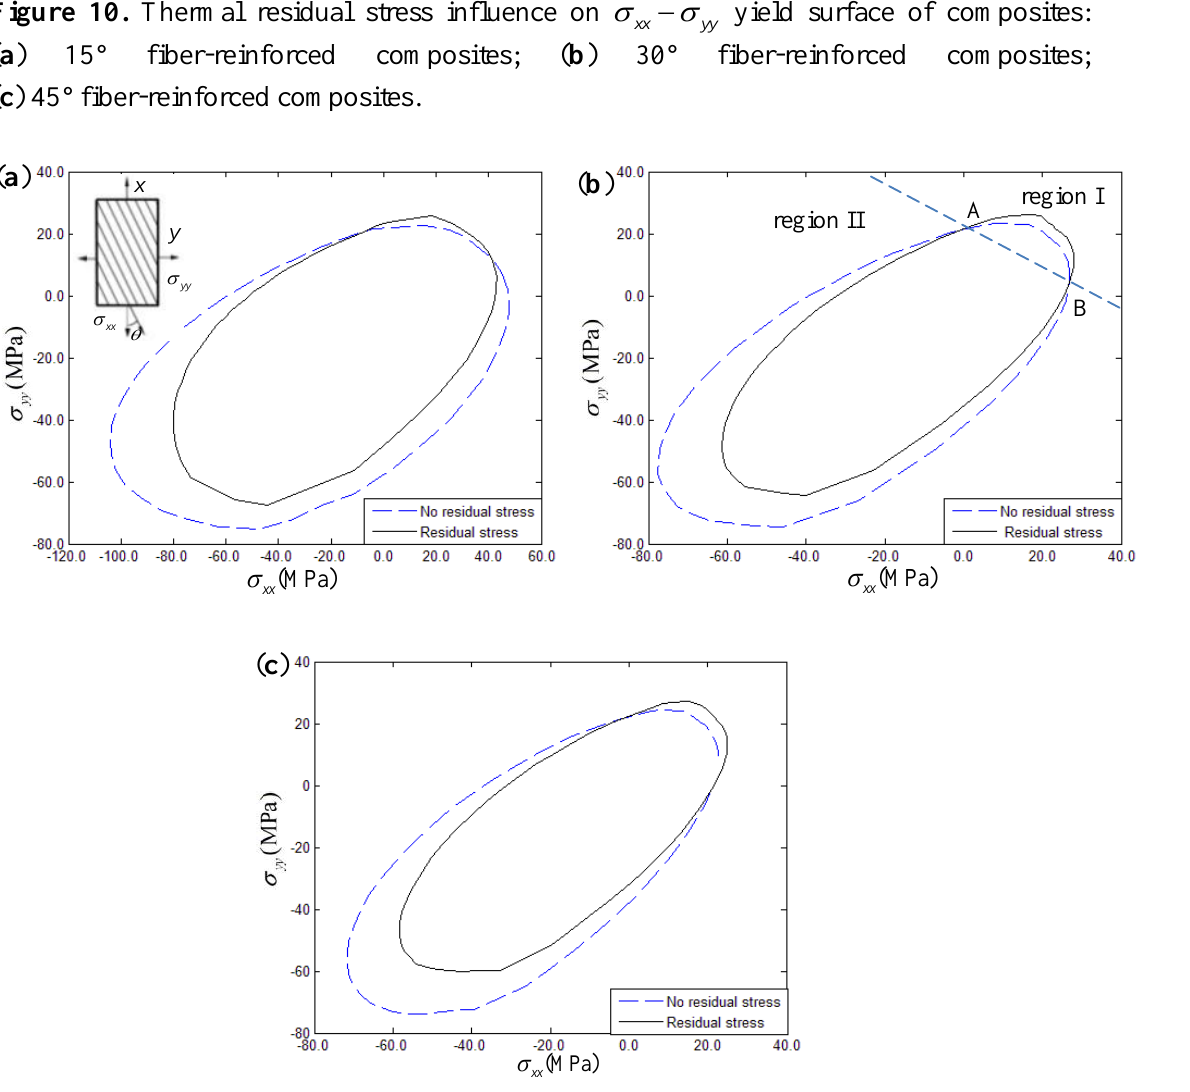
Figure 10. Thermal residual stress influence on